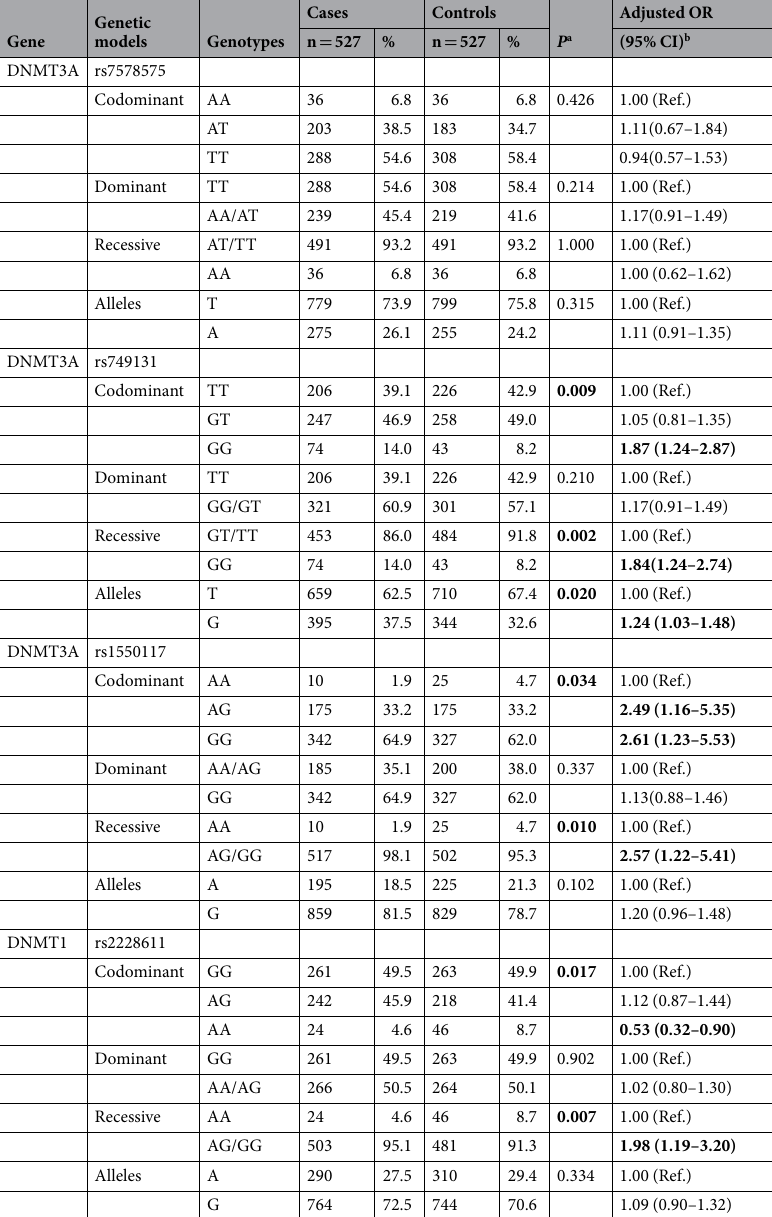
Table 3. Distribution of four polymorphisms and the association with NIHL. a Two-sided χ 2 test. b Adjusted for age, sex, smoking, drinking in logistic regression model.